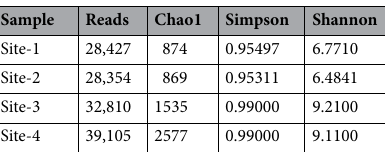
Table 2. Analysis of microbial richness and diversity. Chao1 indicates richness, Shannon and Simpson indicate diversity.